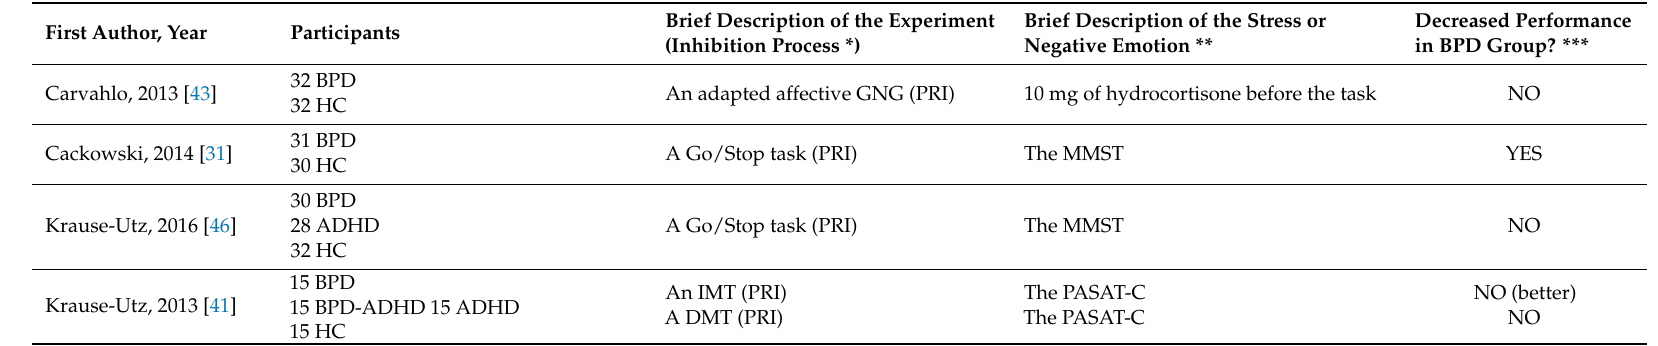
Table 2. Results of 15 studies without self-reference processes during the emotional or stressful